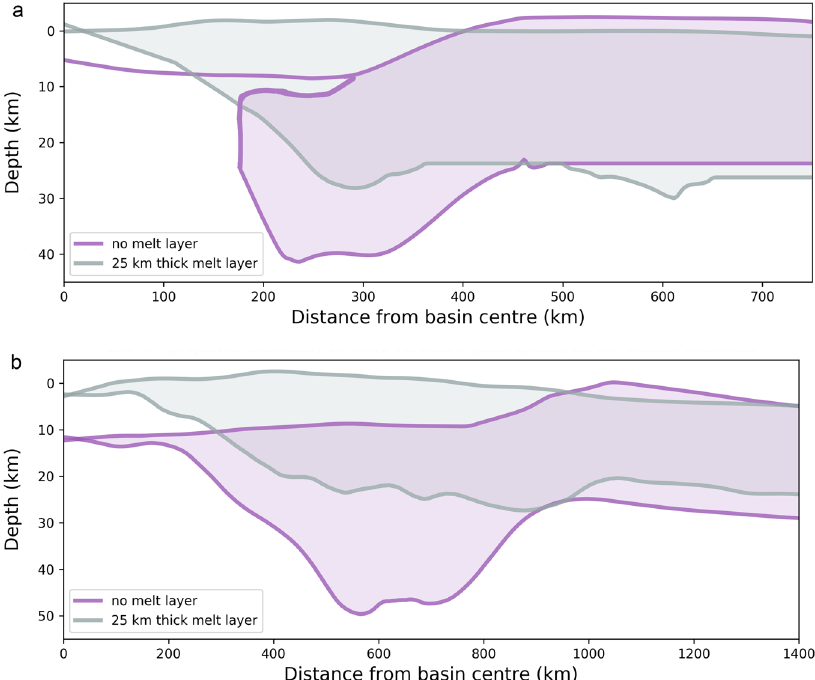
Fig. 4 Radial pro fi les of the surface relief and crust-mantle interface at the end of the simulations. Both panels showing for the case where a 25-km thick melt layer is present between the crust and mantle (grey outline) and when the melt layer is absent (purple outline). a impact basins forming by a 60- km diameter projectile, and b impact basins forming by a 120-km diameter